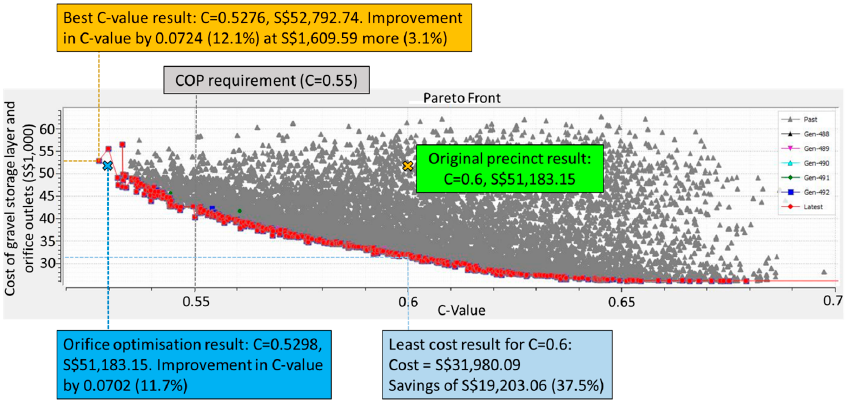
Figure A2. Pareto plot of the multi-objective optimisation of the cost of gravel layer cum orifice outlets and effective C-value of the precinct.